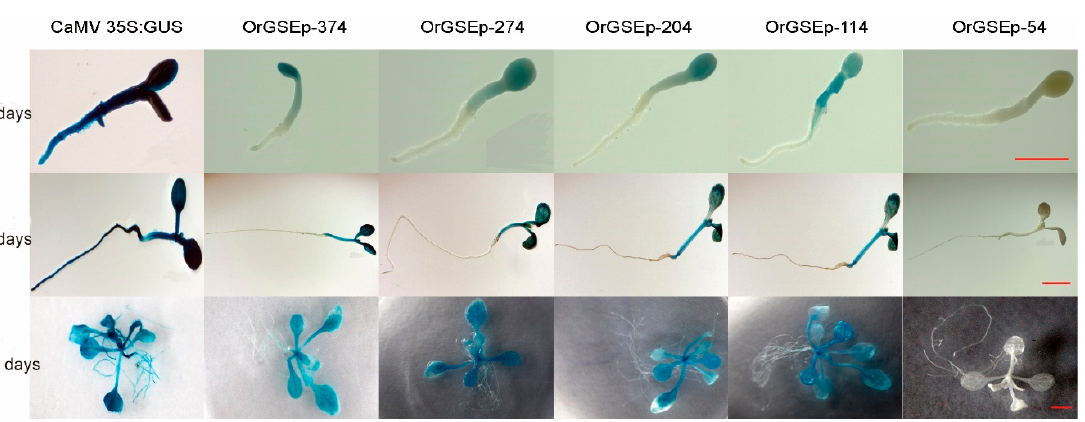
Figure 3. GUS histochemical assays in transgenic Arabidopsis T3 seedlings. GUS histochemical assays in transgenic Arabidopsis T3 seedlings harboring constructs with GUS expression driven by the CaMV 35S promoter (35S: GUS), OrGSEp-374 (OrGSEp-374) and different 5 ′ -deletion fragments (OrGSEp-274, OrGSEp-204, OrGSEp-114 and OrGSEp-54), during vegetative growth. Photographs were taken 3 days, 5 days and 14 days after seed germination.Bar = 1 cm.